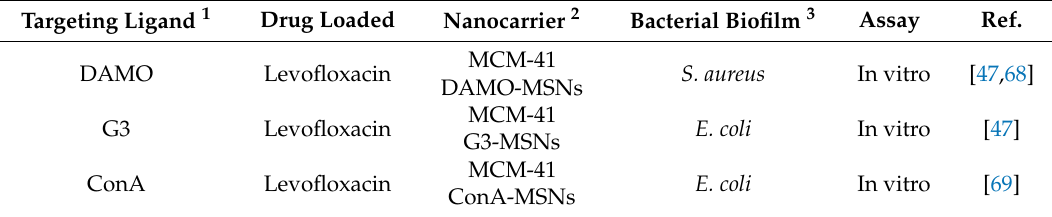
Table 2. Bacterial biofilm-targeted MSNs as antimicrobial delivery